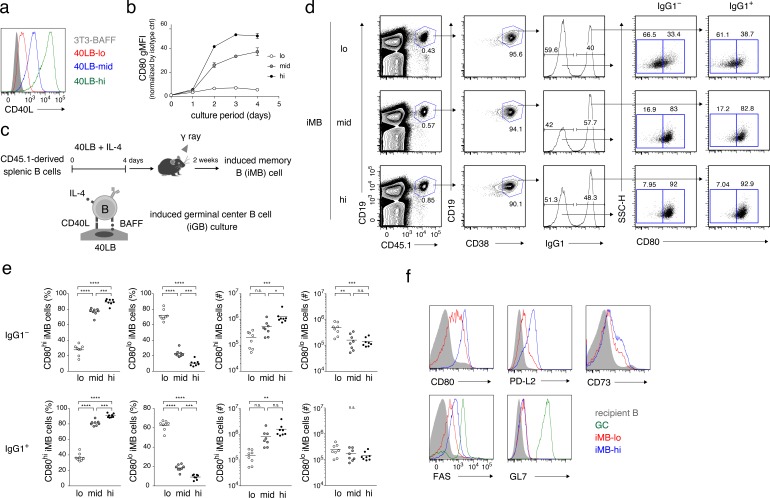
The quantity of CD40 signaling determines the differentiation of B cells into distinct Bmem cell subsets.(a) Expression of CD40L on 3T3-BAFF cells and 40LB sublines (40LB-lo, 40LB-mid, and 40LB-hi) was analyzed by FCM. (b) Splenic B cells were cultured with IL-4 for the indicated number of days on feeder layers of each 40LB subline. The expression of CD80 on the expanded B (iGB) cells was analyzed by FCM and presented as gMFI (mean of triplicates). (c) A schematic representation of a method used to generate the induced memory B (iMB) cells. Splenic B cells from CD45.1+ congenic B6 mice were cultured for 4 days, as in (b). The resultant iGB-lo, iGB-mid, or iGB-hi cells were transferred intravenously (i.v.) into γ-irradiated mice (CD45.2+), and the donor-derived Bmem-like cells (CD19+ CD45.1+ CD38+) detected in the recipient spleens 2 weeks after the transfer were designated iMB-lo, iMB-mid or iMB-hi cells, respectively. (d–f) Expression of CD80 on IgG1+ or IgG1– iMB cells (iMB-lo, iMB-mid or iMB-hi) generated as in (c) was analyzed by FCM. (d) Representative data showing the gating strategy. (e) The frequencies of CD80hi and CD80lo cells among the IgG1+ or IgG1– iMB cells (%) and their absolute number per spleen (#) are plotted (n = 8). (f) Expression of the indicated surface markers on the recipient total B cells (CD45.1− CD19+), spontaneous GC B cells (CD45.1− CD19+ CD38− GL7+), the iMB-lo and the iMB-hi cells (CD19+ CD45.1+ CD38+). The mean of the values in each group is indicated by a horizontal bar (e). n.s., not significant (p>0.05); *, p<0.05; **, p<0.01; ***, p<0.001; ****, p<0.0001; as determined by one-way ANOVA followed by Tukey’s multiple comparisons test (e). All data are representative of two independent experiments except (e), where data from two independent experiments are combined.10.7554/eLife.44245.010Figure 3—source data 1.Source data for Figure 3b and e.